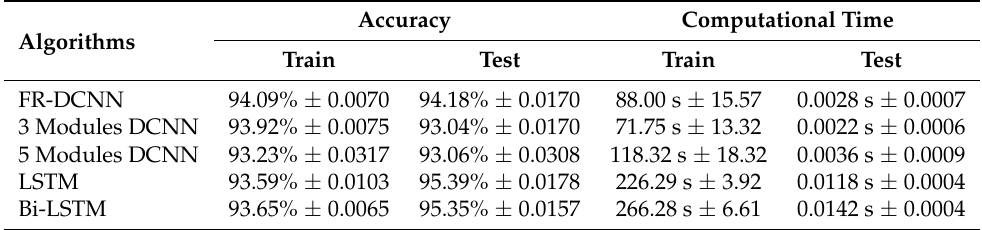
Table 1. The comparison performance on the compressed training dataset ( ζ = 0.5) among FR-DCNN, DCNN, LSTM, and Bi-LSTM.